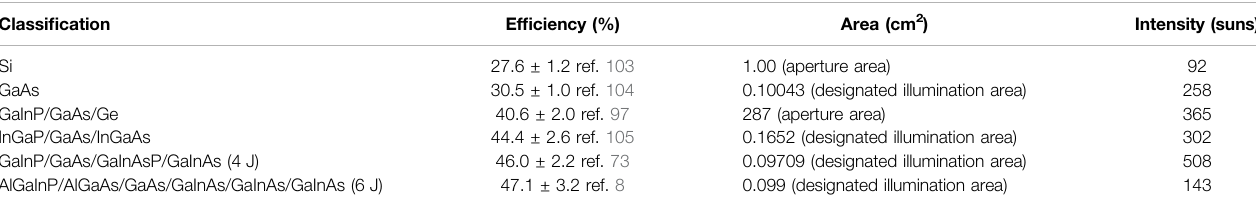
TABLE 4 | Comparison of the ef fi ciency of various types of solar cells under concentrated sunlight. Classi fi